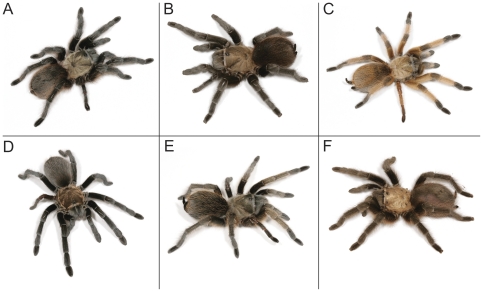

Aphonopelma species represented in this analysis.Sampled species consist of A – A. hentzi; B – A. anax; C – A. moderatum; D – A. armada; E – A. sp. Carlsbad Green; F. A. sp. nov 1. A. sp. nov 2 is not pictured.